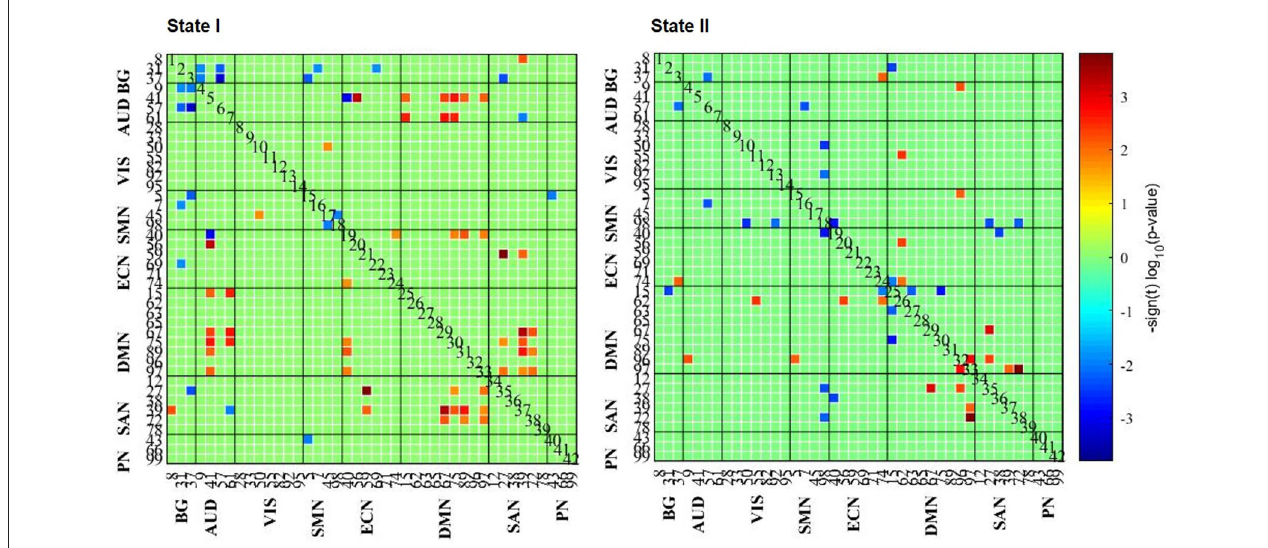
FIGURE 4 | The results of FC strength in each state. The results of the two-sample t -test of HC and AD groups are listed, where the AD group had a weaker or stronger FC pattern in comparison with the HCs.